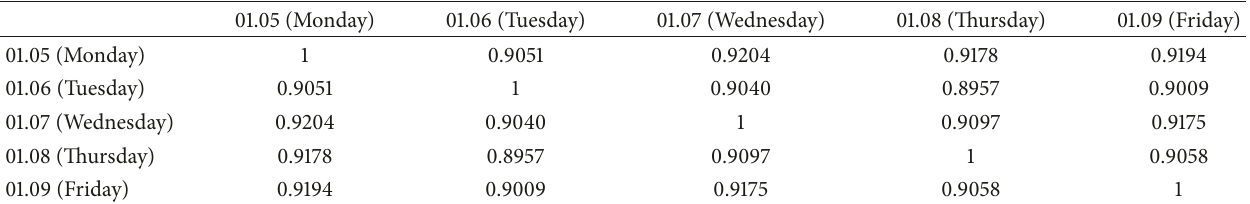
Table 7: Correlation coefficient matrices of two traffic volume series from the same detector located at urban arterial road but in five consecutive working